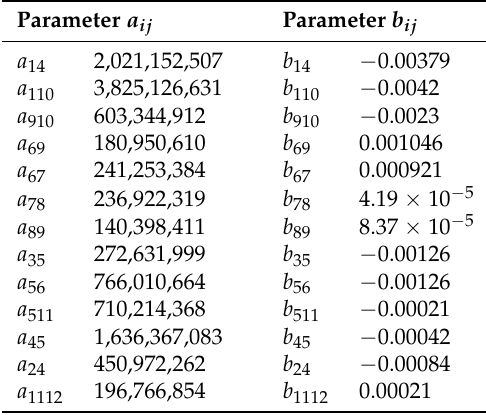
Table 2. Parameters a ij and b ij , which come from Equations (13) and (14).